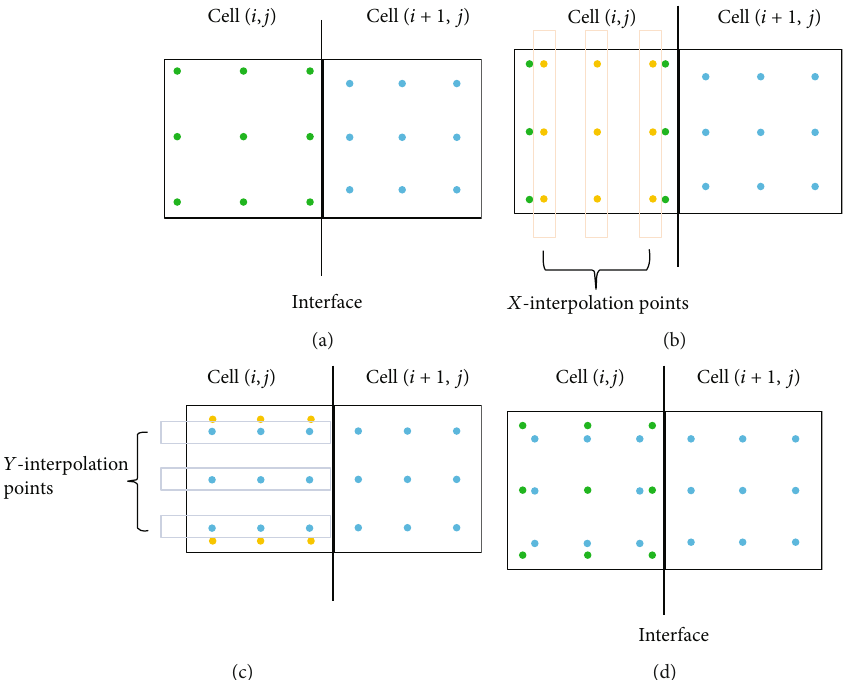
Figure 5: 2D di ff erent points near the interface of hybrid scheme. (a) 2D grid and di ff erent solution points. (b) 2D x direction interpolation. (c) 2D y direction interpolation. (d) 2D ghost points.